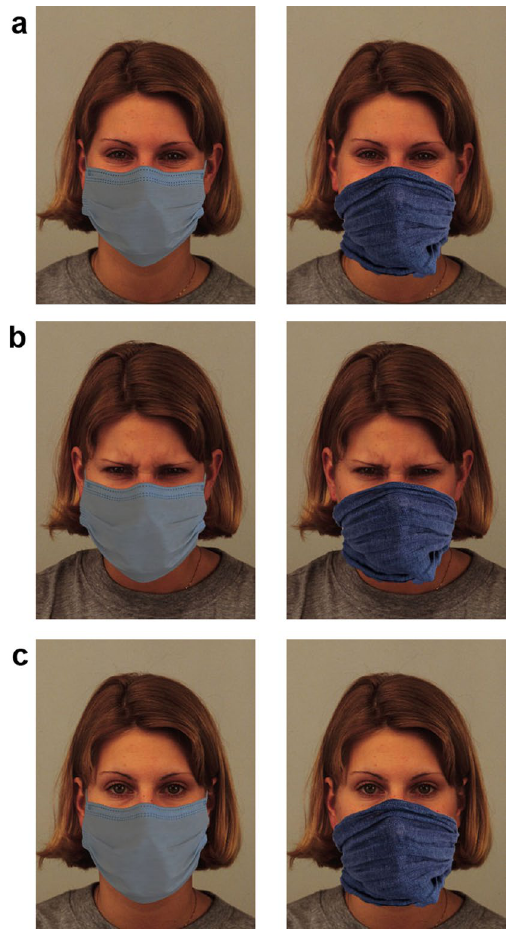
Figure 1. Example of stimuli. ( a ) Happiness, ( b ) Anger, ( c ) Neutral, in the two conditions of covering: sanitary mask—HP (shown on the left) and scarf—LP (shown on the right). The faces were taken from the Karolinska Directed Emotional Faces picture set—KDEF. The depicted face is